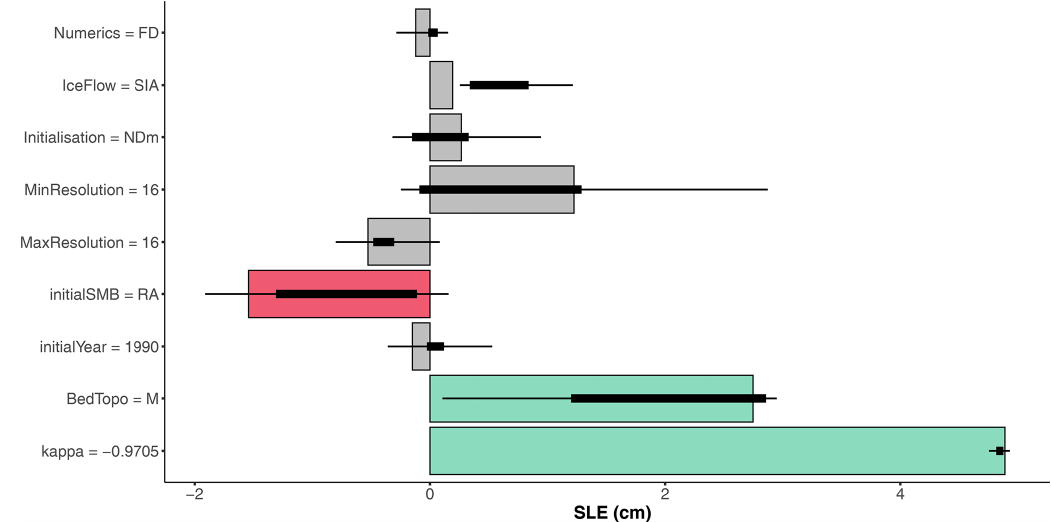
Figure 10. Robustness analysis of the local importance analysis for the largest simulated sl value in 2100 (Case (a) in Fig. 6). The horizontal coloured bars correspond to the quantified contributions by including all input variables (results of Fig. 6a). The endpoints of the thick and thin horizontal black error bars are the minimum/maximum and the percentiles at 25% and 75% respectively computed when iteratively excluding one of the nine input